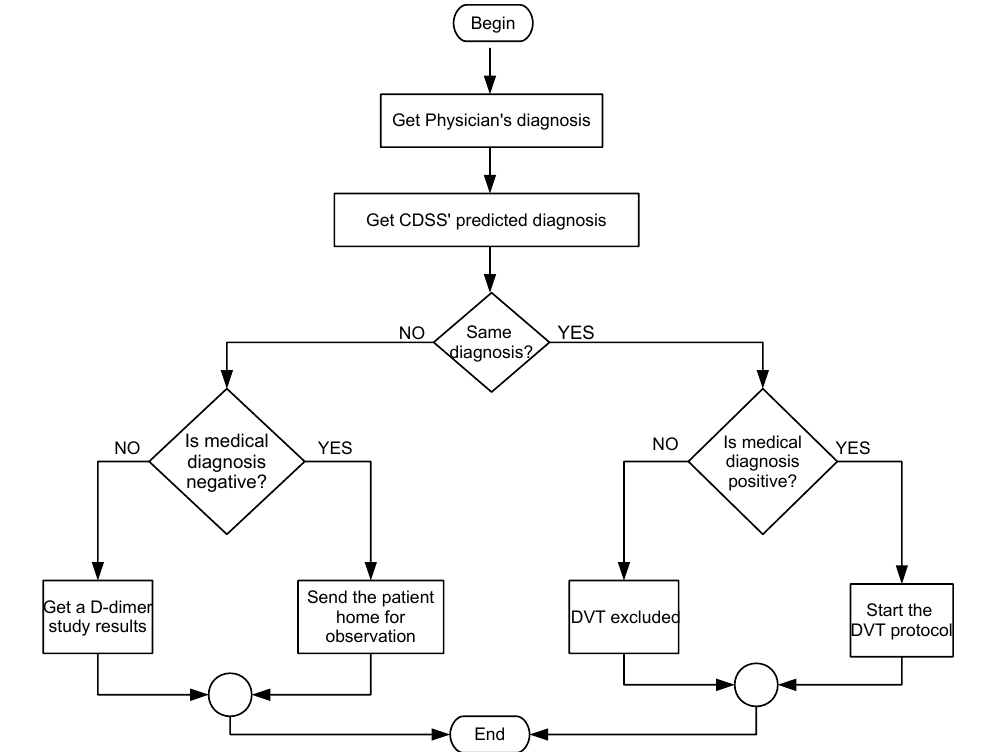
Figure 11. Suggested use of the proposed CDSS in primary care